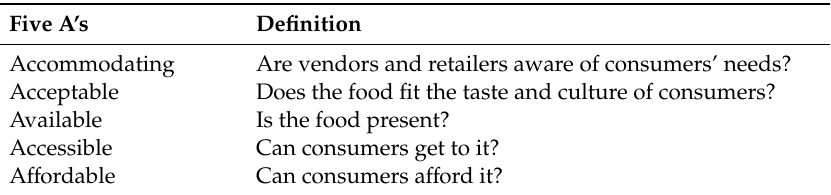
Table 4. Five A’s of Food